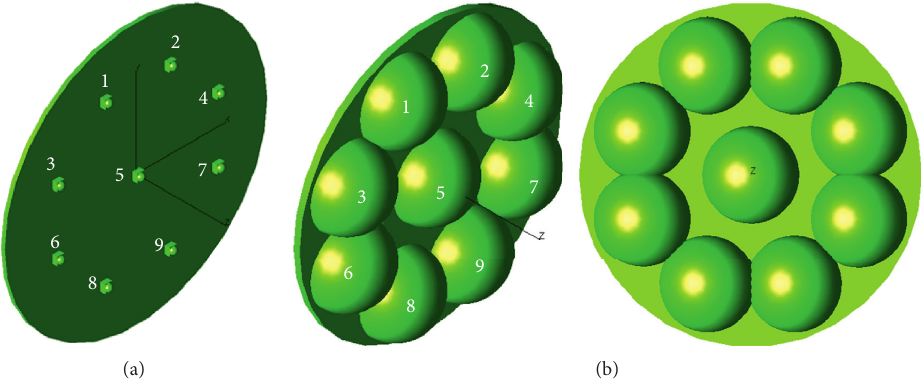
Figure 1: The structure of (a) LED array and (b) sunflower-shaped lens array.